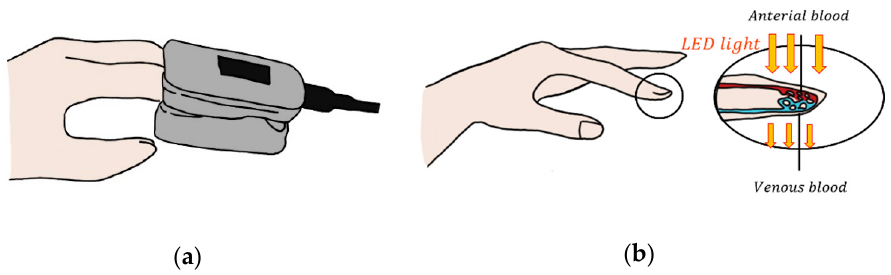
Figure 7. ( a ) The shape of a fingertip photoplethysmography (PPG); ( b ) transmitted